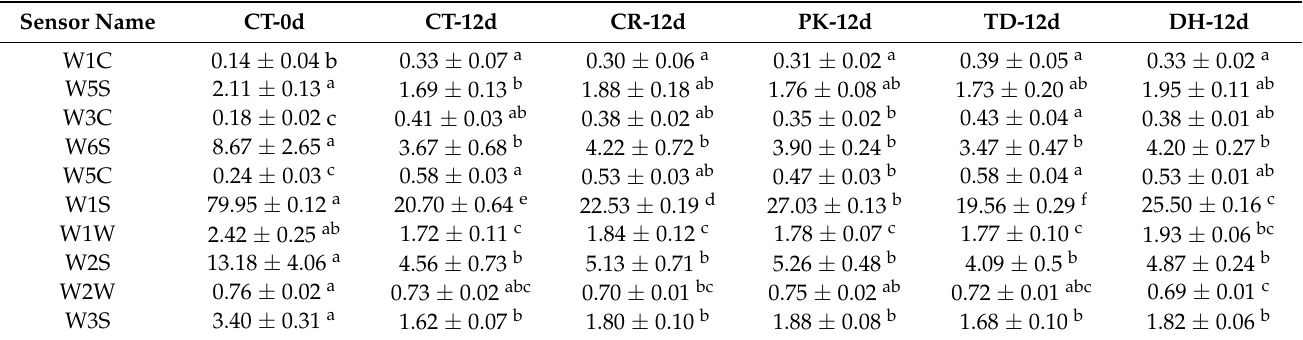
Table 4. Response values of electronic nose sensors of the control and reduced-salt dry sausages with and without yeast inoculation on days 0 and